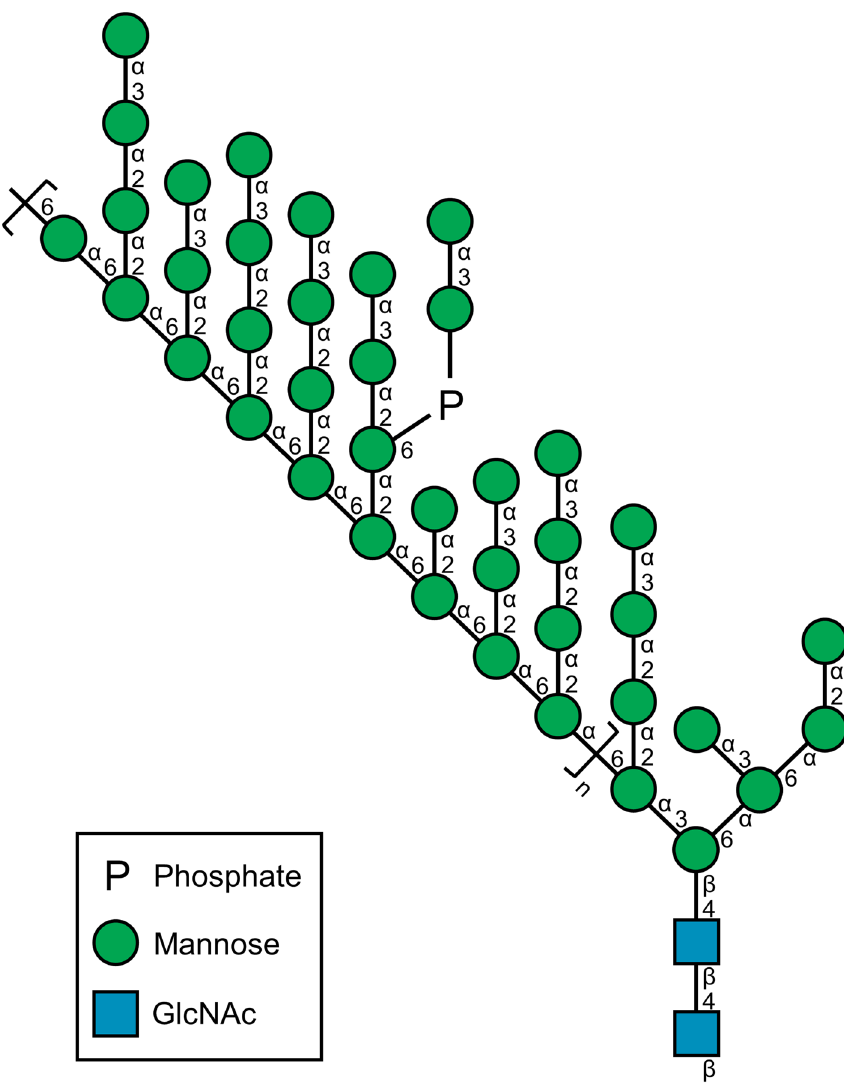
Figure 1. A correct version of the original Figure